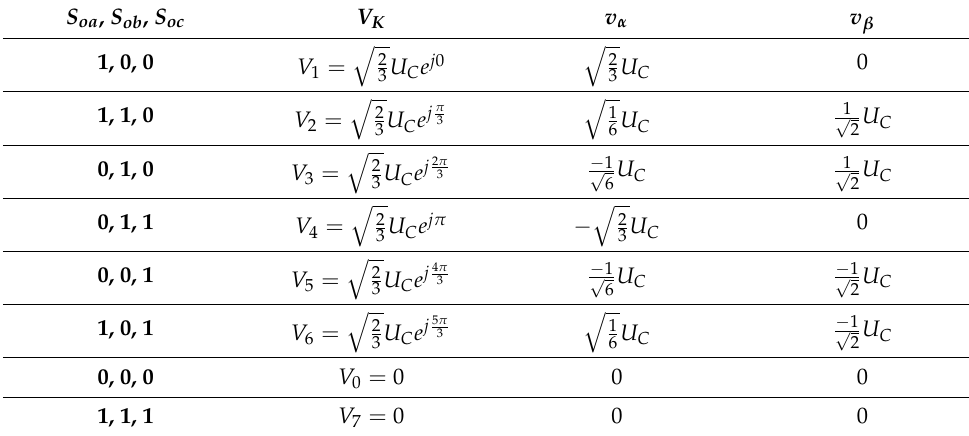
Table 3. Voltage vectors and switching